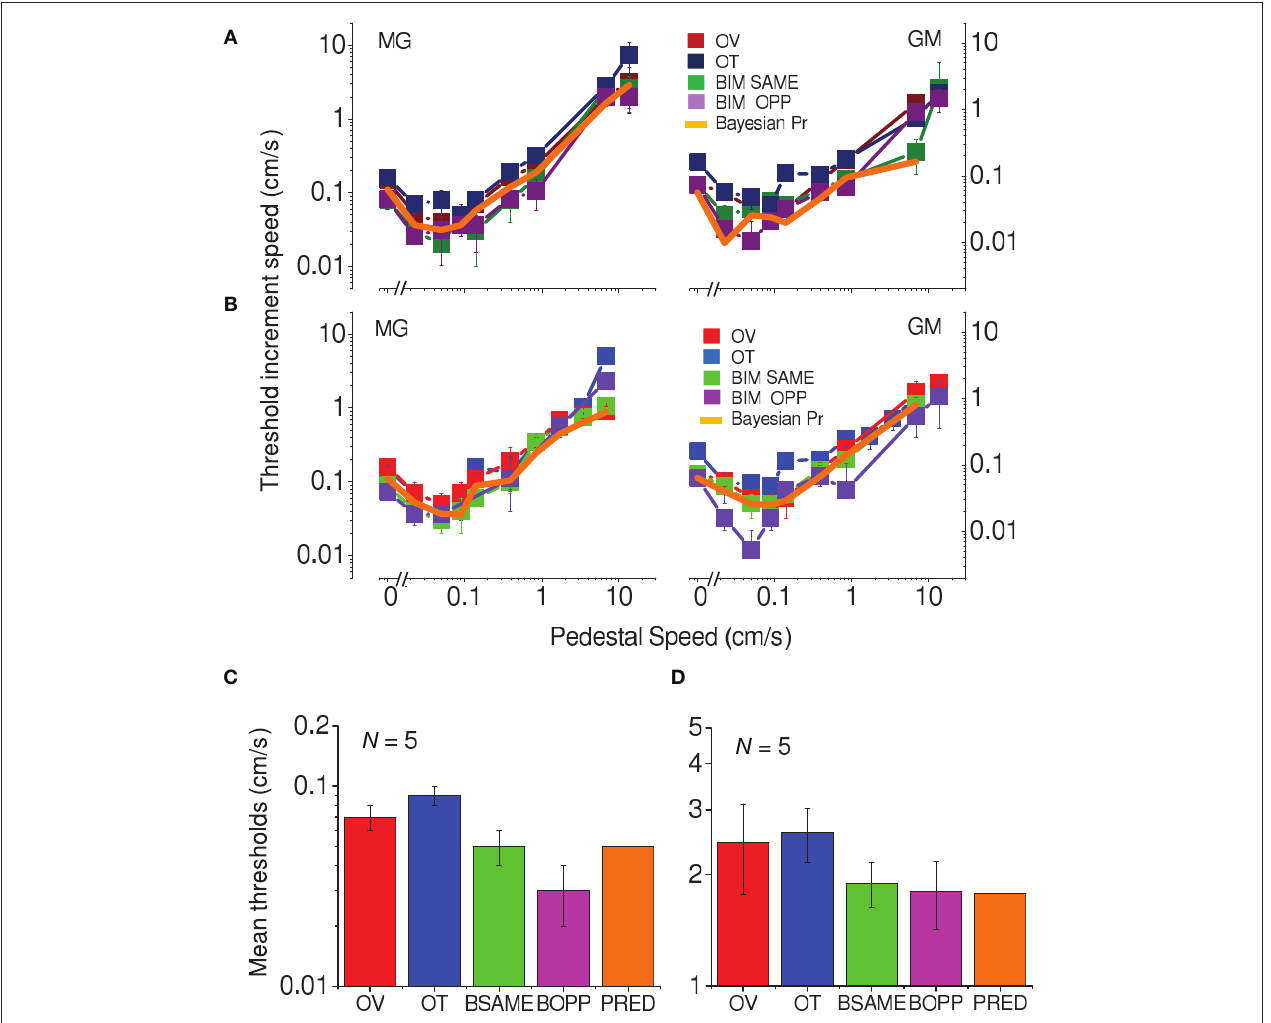
Figure 4 | Speed thresholds for summation between modalities. (A) Spatial frequency of 3.3 cycles/cm. Thresholds for vision only are reported in dark red, for tactile only in dark blue and for bimodal in dark green. Thresholds for bimodal same direction condition light green, for bimodal opposite direction light violet, Bayesian prediction orange (replicated in two subjects). (B) Spatial frequency of 10 cycles/cm. Thresholds for vision only are reported in light red,